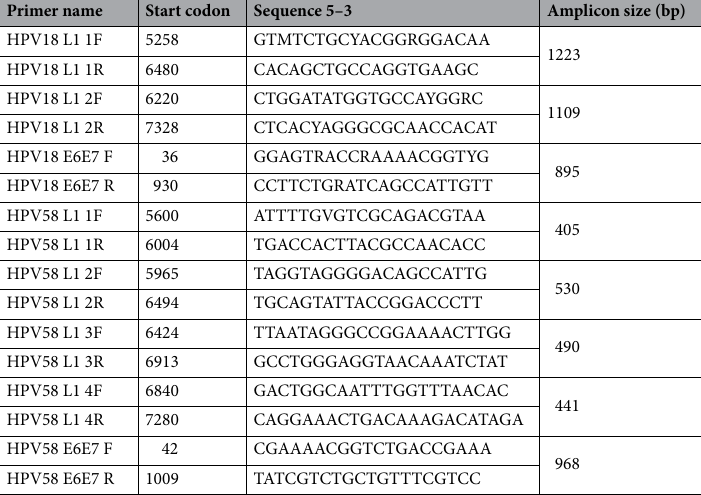
Table 7. Primers used for the amplification of HPV18 and HPV58 L1, E6 and E7